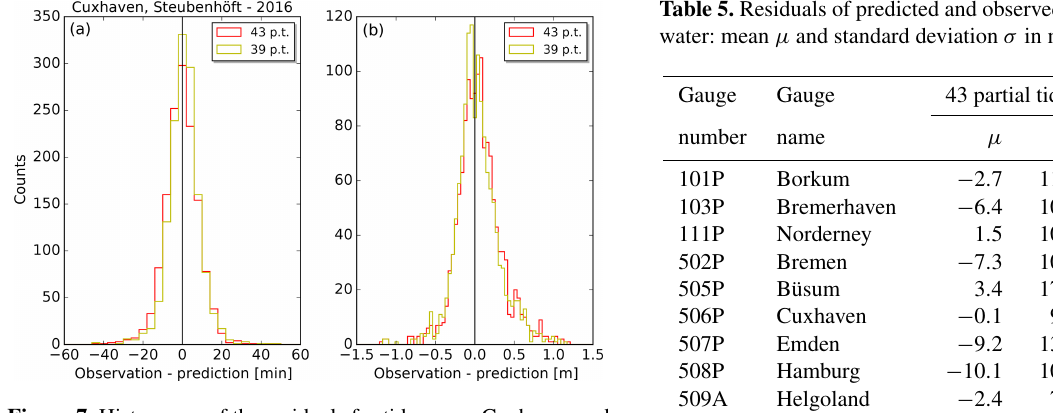
Figure 7. Histograms of the residuals for tide gauge Cuxhaven and year 2016. The different colours indicate predictions based on the different sets of partial tides (red: predictions with 43 partial tides; yellow: predictions with 39 partial tides). (a) Time differences with a bin width of 4min. (b) Height differences with a bin width of 0.04m.